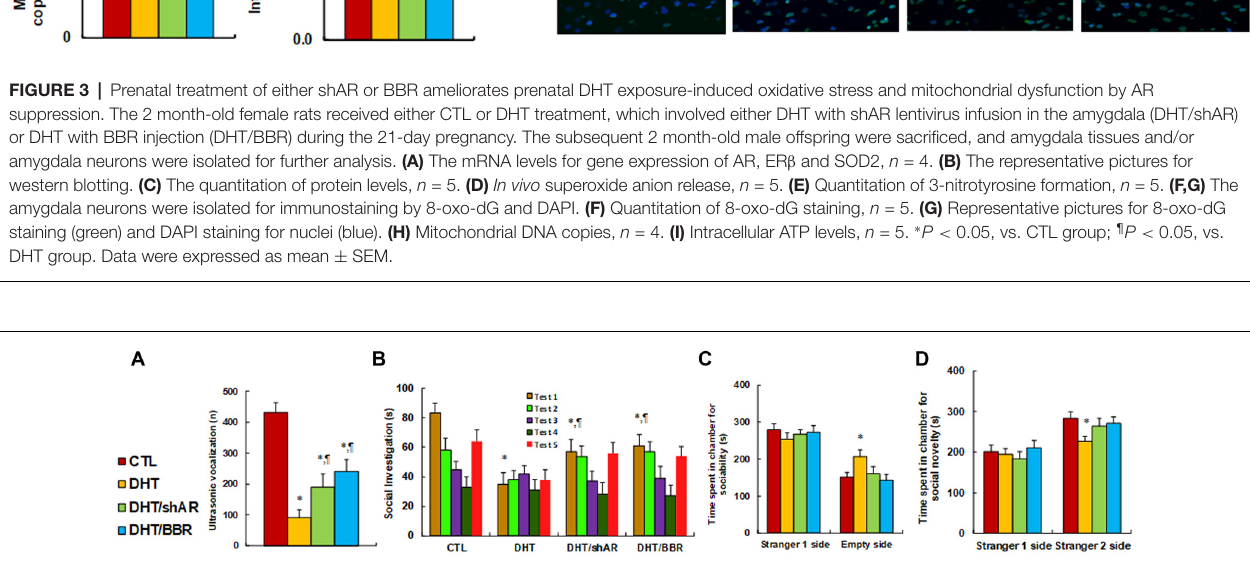
FIGURE 4 | Prenatal treatment of either shAR or BBR ameliorates prenatal DHT exposure-induced autism-like behavior (ALB) in offspring. The 2-month female rats received either CTL or DHT treatment, which involved either DHT with shAR lentivirus infusion in the amygdala (DHT/shAR) or DHT with BBR injection (DHT/BBR) during the 21-day pregnancy and the subsequent 2-month old male offspring were used for ALB analysis. (A) Ultrasonic vocalization, n = 9. (B) Social recognition, seconds spent socially investigating a conspecific [same conspecific in tests 1–4; novel conspecific in test 5 (a new stimulus rat was introduced)], n = 9. ∗ P < 0.05, vs. CTL group; ¶ P < 0.05, vs. DHT group. (C,D) Three-chambered social tests, n = 8. (C) Time spent in the chamber for sociability. (D) Time spent in the chamber for social novelty. ∗ P < 0.05, vs. CTL group. Data were expressed as mean ± SEM.